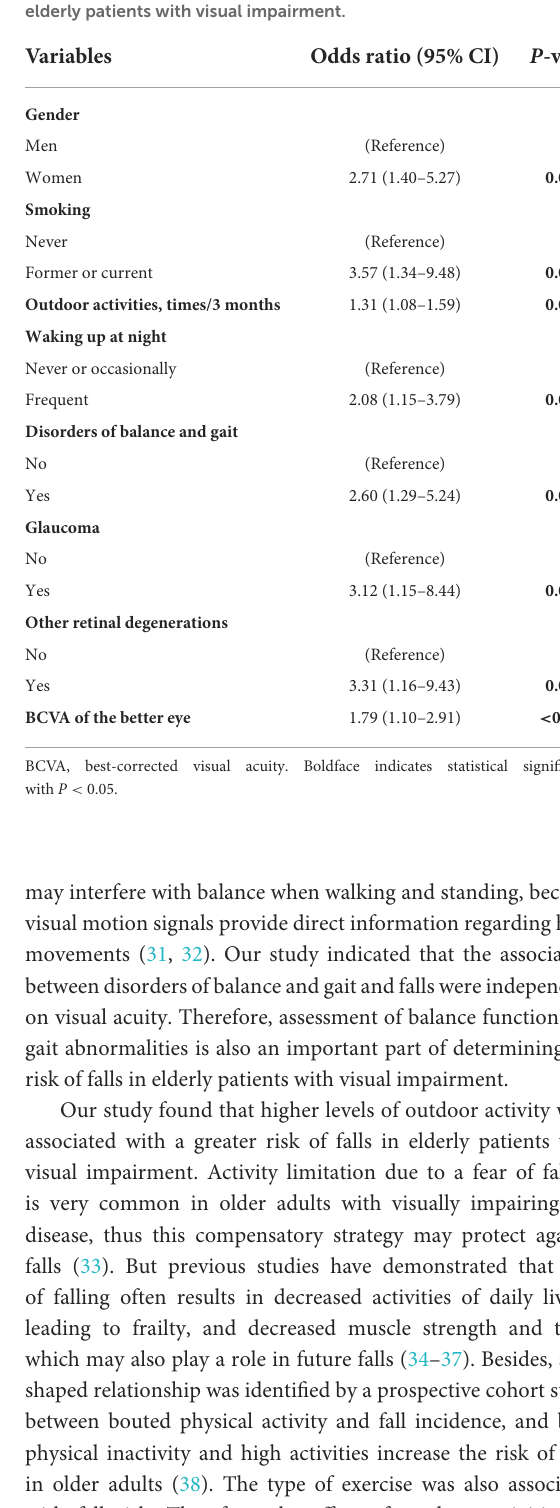
TABLE 4 Stepwise multivariate logistic regression for fall risk in elderly patients with visual